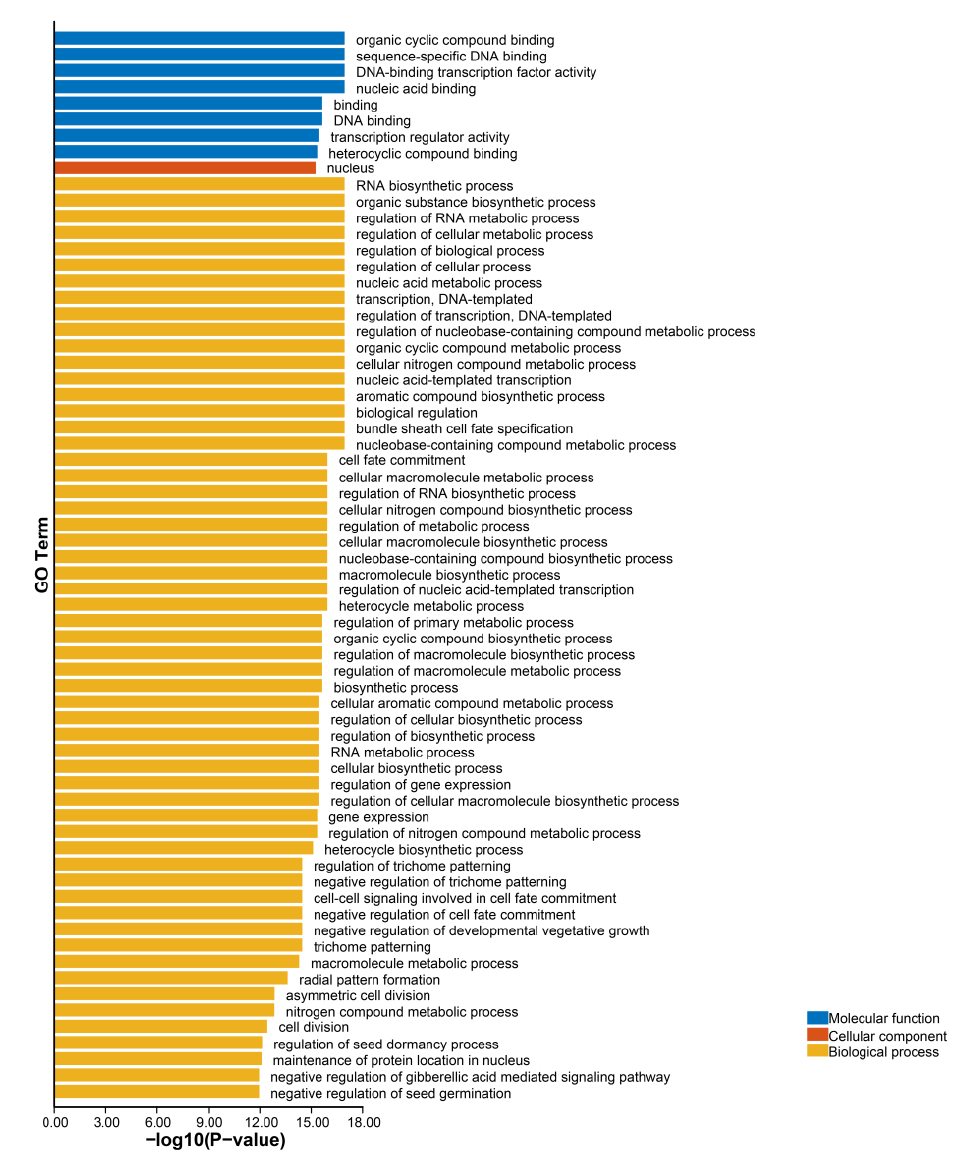
Figure 6. GO annotation of GRAS protein sequences.